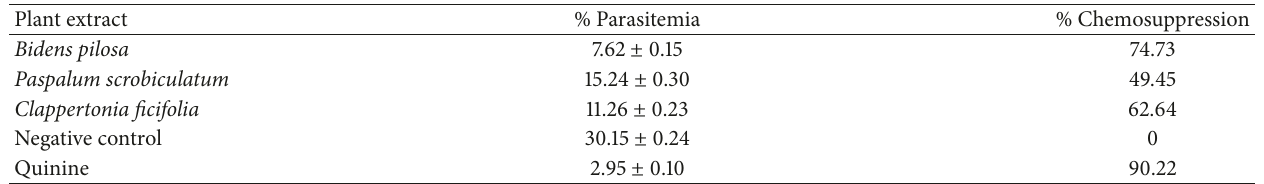
Table 5: Average parasitemia and percent chemosuppression of plant extracts in 4-day suppressive test. Plant